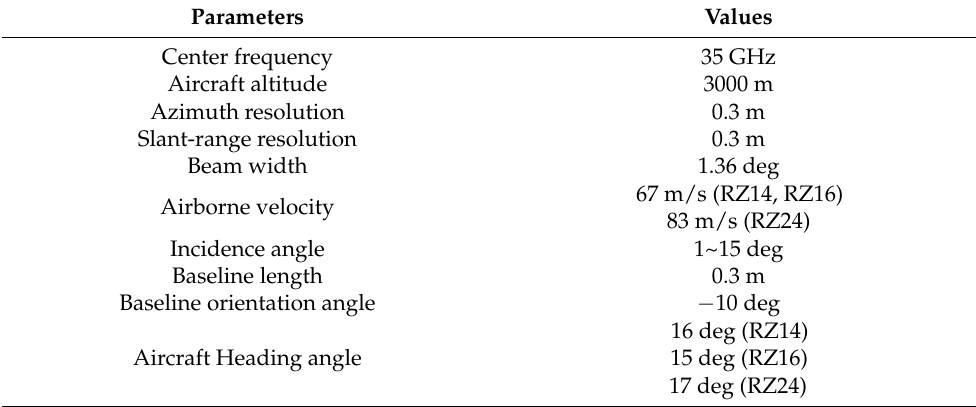
Table 1. Master parameters of the airborne